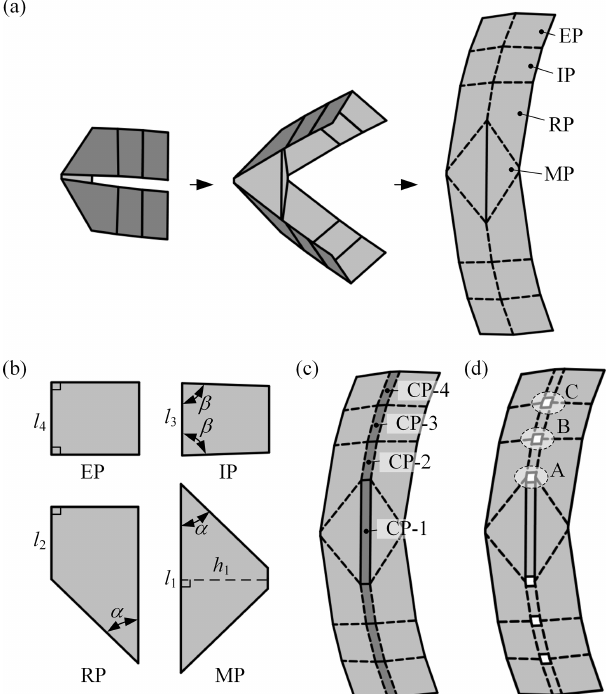
Figure 3. Design of the deployable string: (a) an origami string consisting of two Miura-ori unit cells and four Bowl-origami unit cells and its deployment process; (b) four types of panels that make up origami string and their geometrical parameters, where α , β ∈ (0 ,π/ 2); (c) adding CPs (CP- i , i = 1–4) in the middle of the origami string; and (d) the deployable string after cutting open the